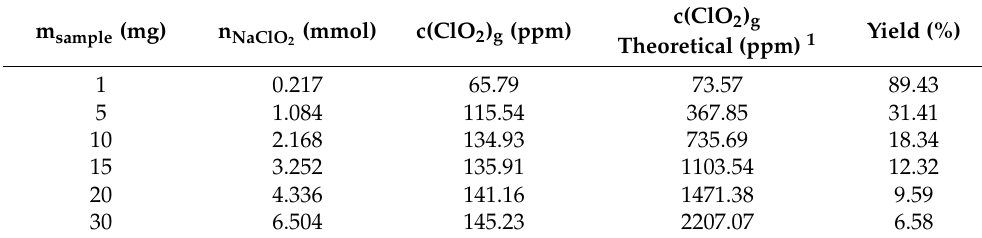
Figure 4. Chlorine dioxide production and chlorine dioxide production per weight of 1, 5, 10, 15, 20 and 30 mg samples. Table 1. Yield of generated ClO 2 by samples of different weights calculated from the theoretical ClO 2 production of sodium chlorite in acidic environment.